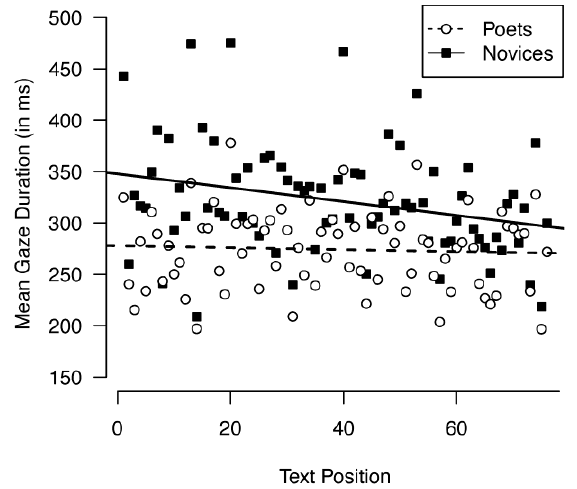
Figure 1. Mean gaze durations during poetry reading as a function of serial text position (1 st word, 2 nd word, …, n th word) and level of expertise (poets vs.